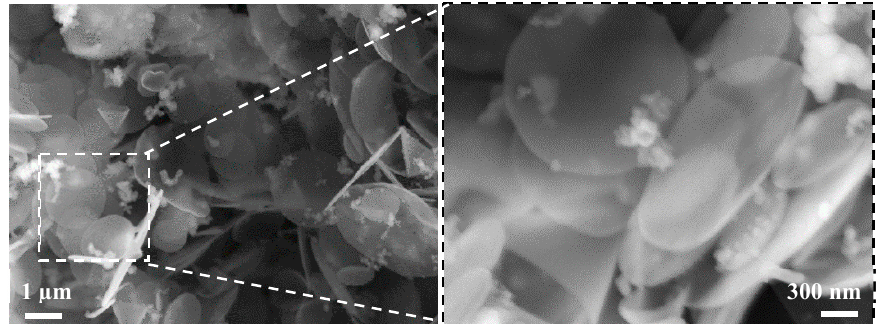
Figure 1. Micrographs of NC obtained by SEM/SE. Table 1. Composition and properties of the CAC used.